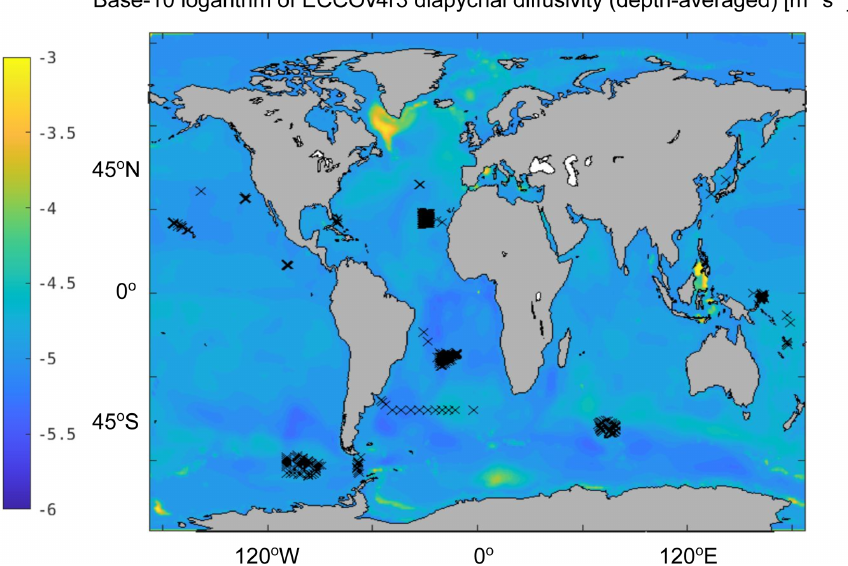
Figure 2. Shown is the base-10 logarithm of κ ρ, ECCO (units in m 2 s − 1 ), depth-averaged over all depths below the average mixed layer depth to exclude very large values within the mixed layer. Black X marks indicate locations where there are microstructure measurements used in this